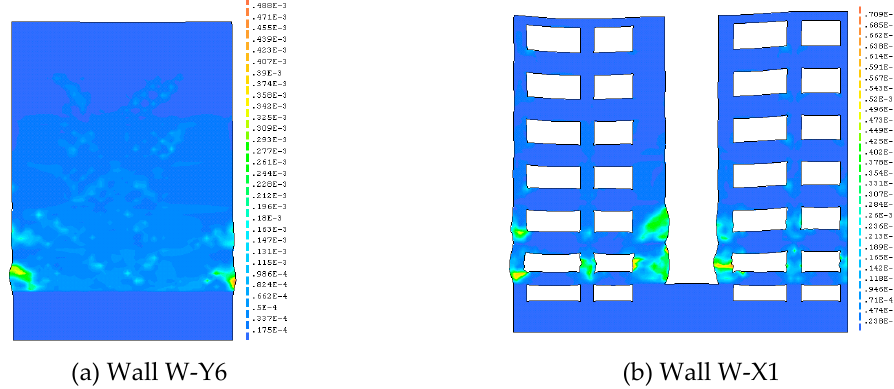
Figure 9. ( a ) Typical diagonal X-shaped crack due to shear in the perpendicular wall; ( b ) concentration of damage at the ground floor in the longitudinal wall (0.1g scaled accelerogram).